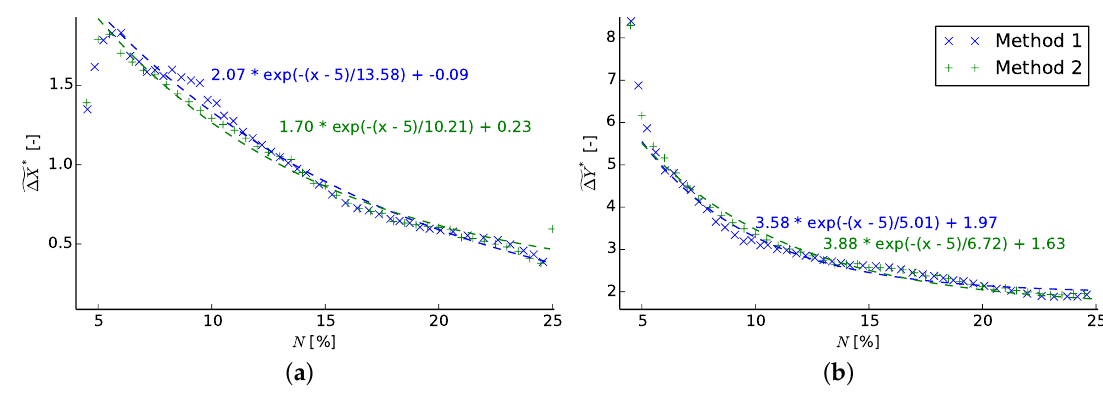
Figure 9. Optimal positions as a function of the objective heat source density. The optimal spacing is presented in the ( a ) horizontal direction and the ( b ) vertical direction.